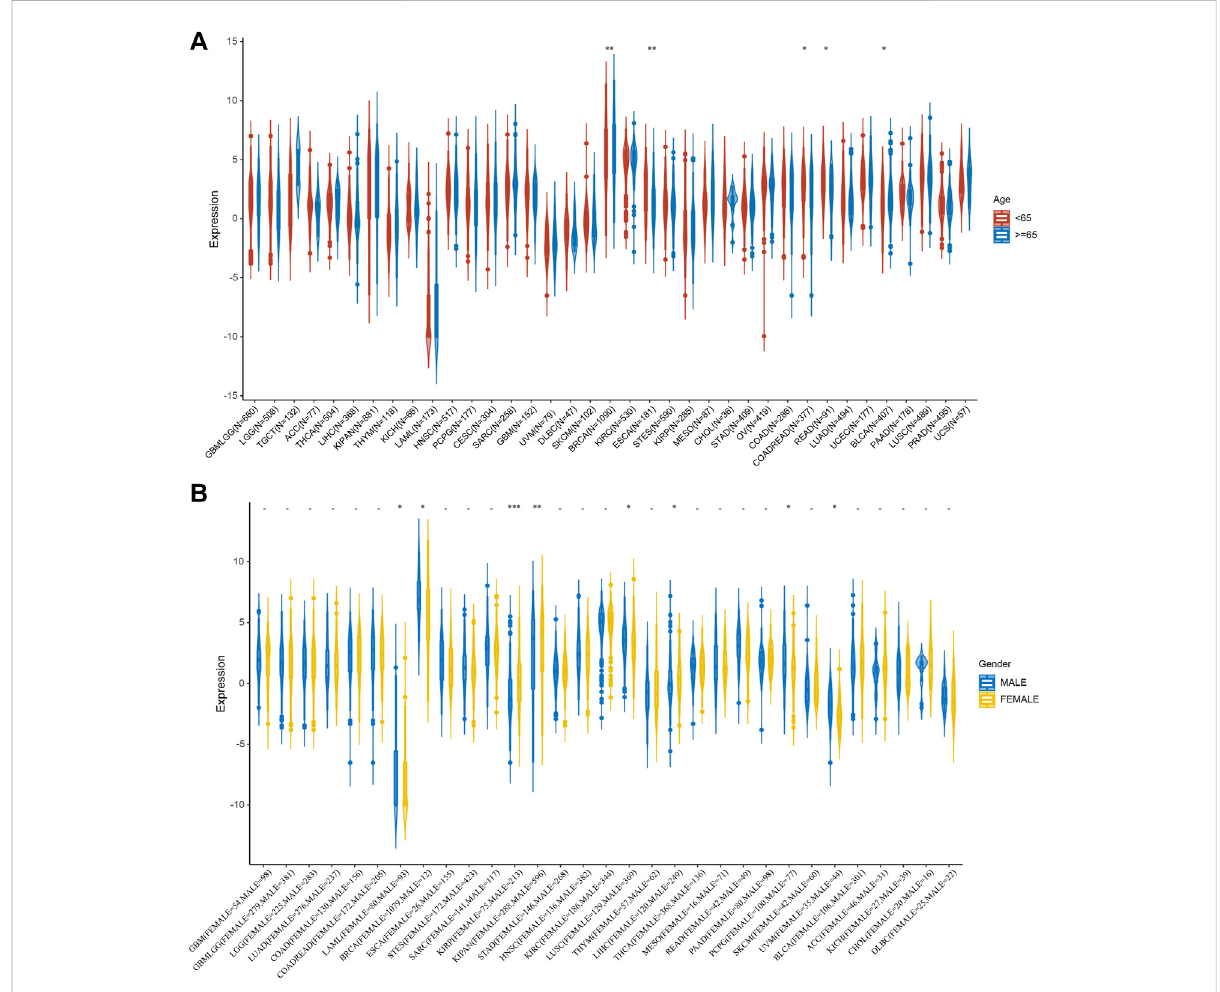
FIGURE 4 Correlation between STC2 Expression and Clinical phenotypes. (A) The relationship between STC2 expression and age; (B) The relationship between STC2 expression and gender. *: p -value < 0.05; **: p -value < 0.01, ***: p -value <